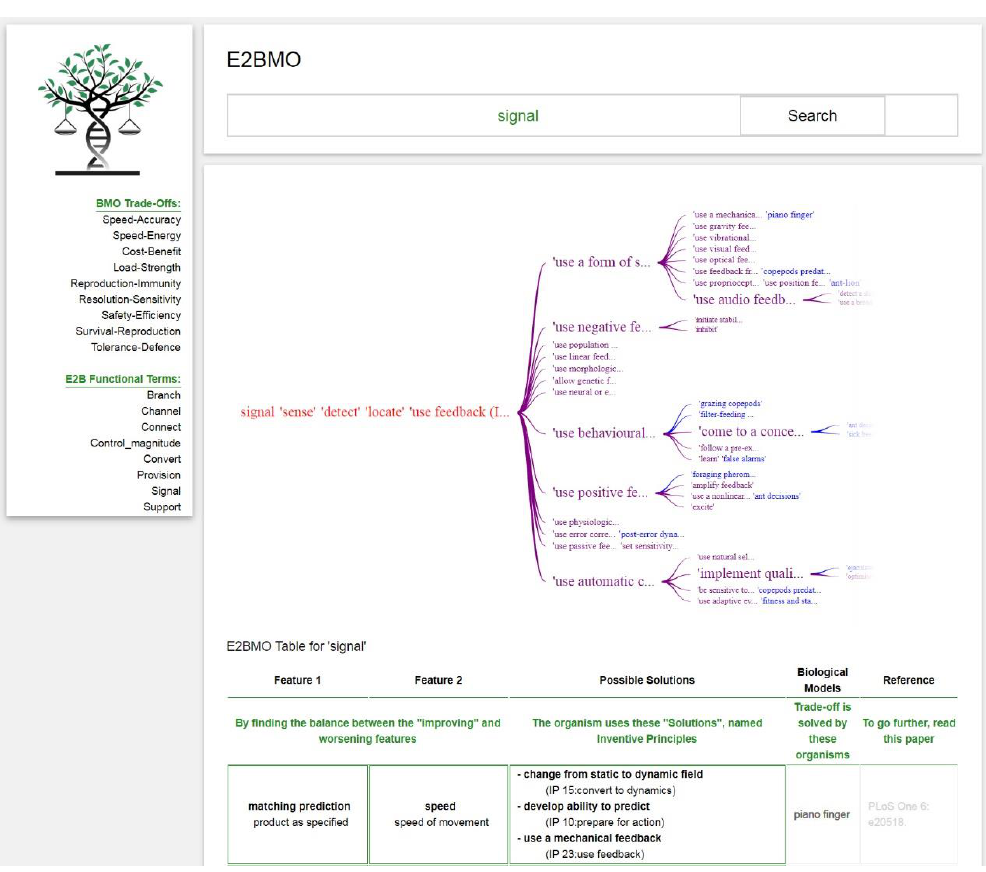
Figure 8. E2BMO query result for E2B functional word ‘signal’ from IPs to biological texts in blue through sub-IPs in purple, results table included on the same page.